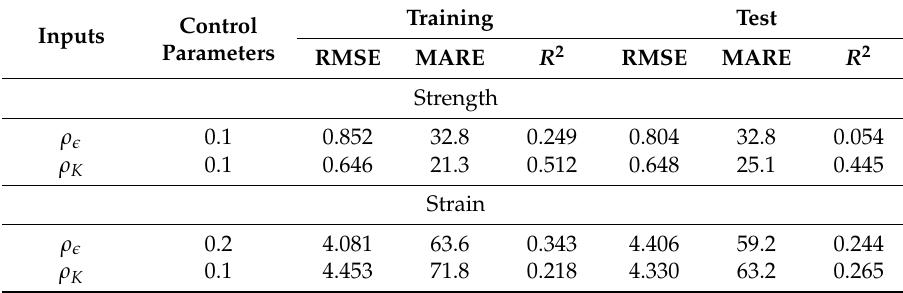
Table 6. Effect of strain ratio ( ρ (cid:101) ) and the confinement stiffness ratio ( ρ K ) inputs on strength and strain with respect to